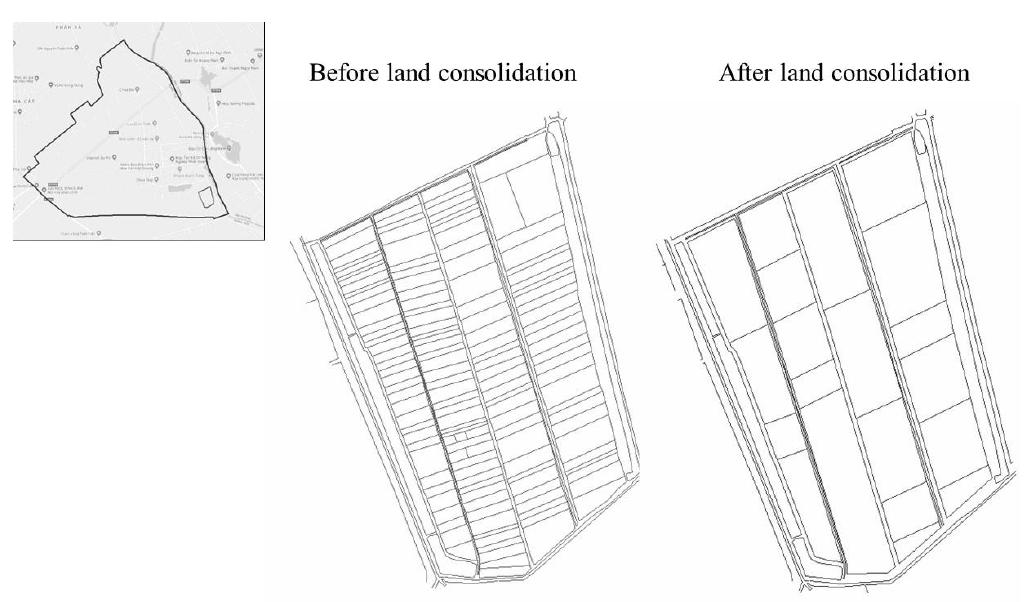
Figure 3. An example map of the pattern of agricultural land parcels before and after the latest land regrouping in Nhat Quang commune, Phu Cu